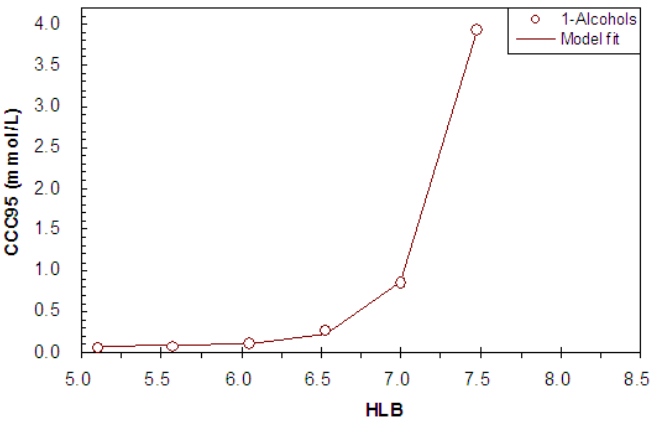
Figure 12. Model (Equation (12)) fit to CCC95 versus HLB data for the 1-Alcohols.